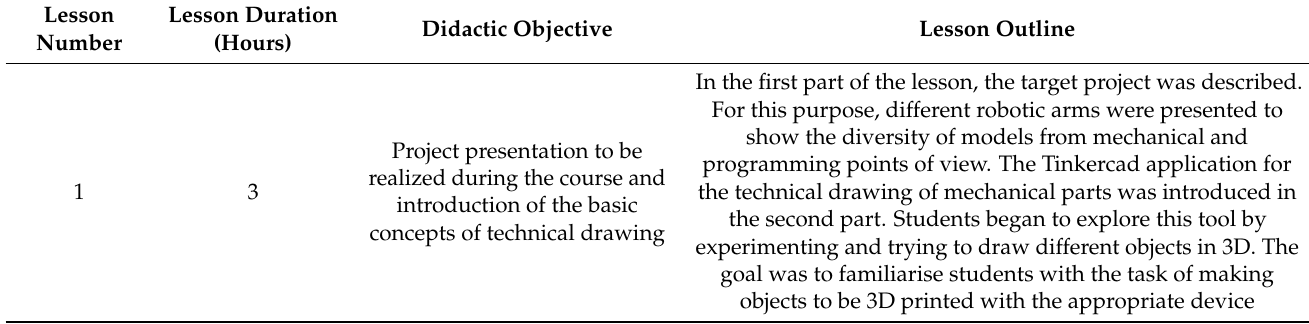
Table 2. Educational module